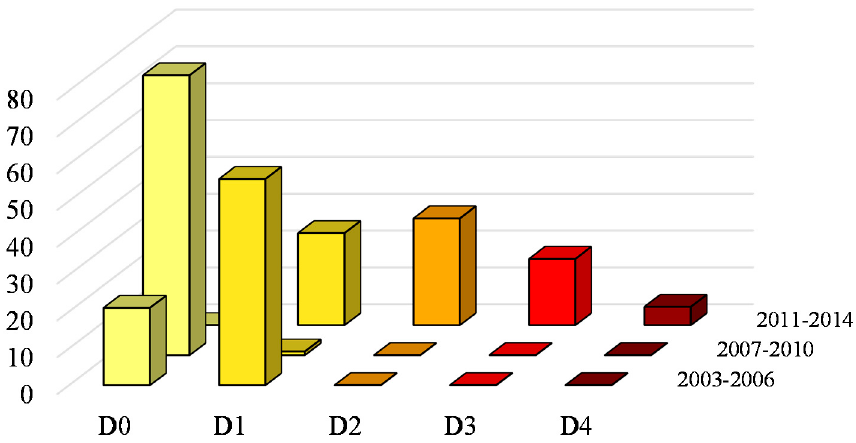
Figure 7. Categorization of averaged drought severity in Oklahoma in 2003–2014. Source: Authors’ calculations and visualization.